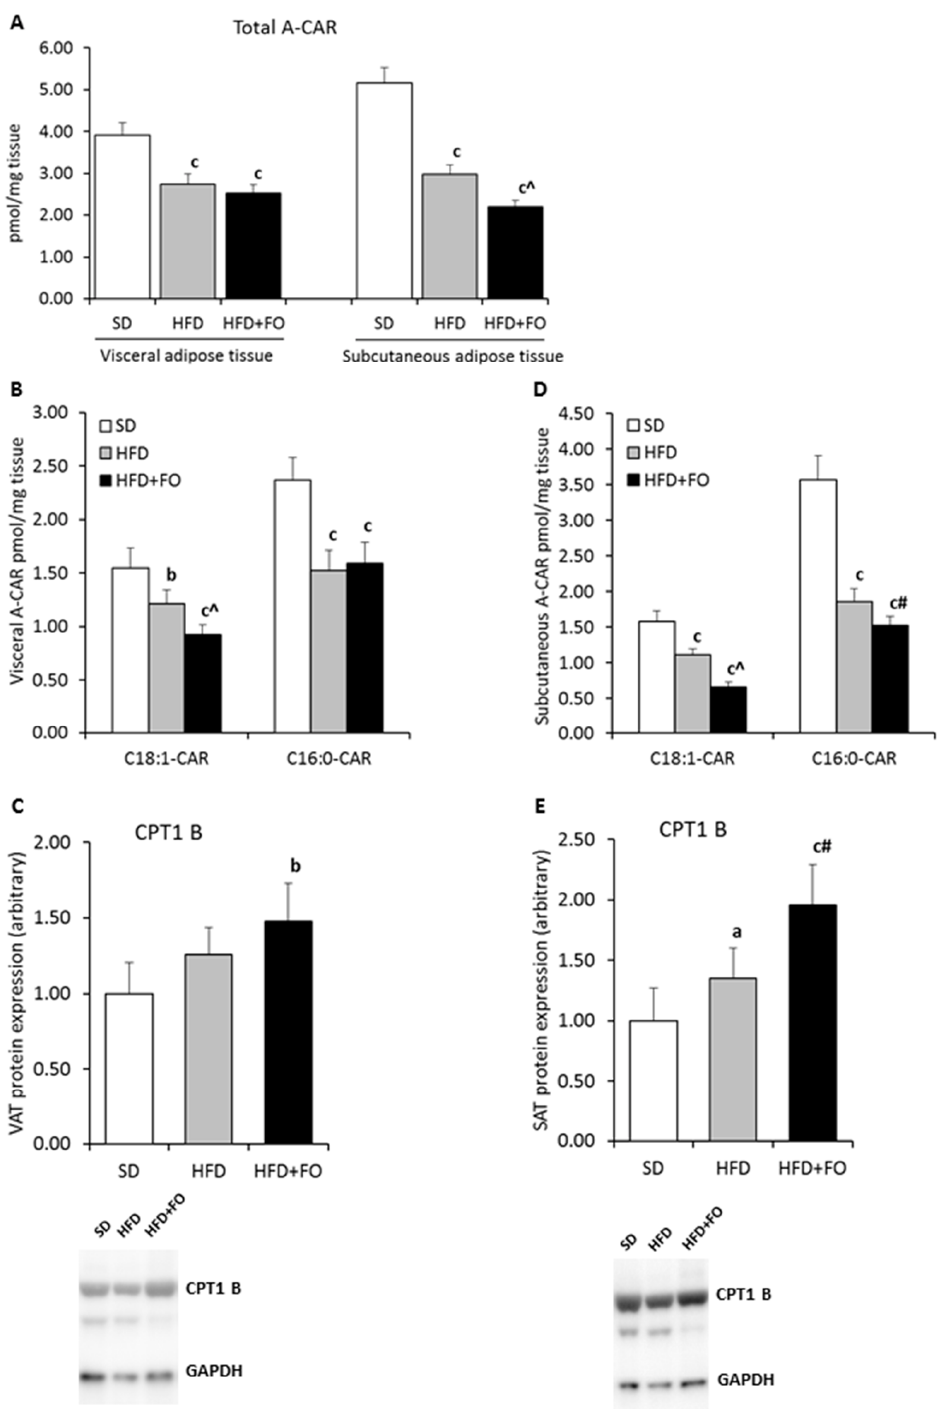
Figure 1. The e ff ect of HFD and HFD + FO consumption on mitochondrial channeling of fatty acids. Panel A presents a total acyl-carnitine (A-CAR) content in rat VAT and SAT, respectively. Panel B and D show the content of A-CAR individual molecular species. Panel C and D present VAT and SAT protein expression of carnitine palmitoyltransferase 1 B (CPT1 B). Values are expressed as mean ± standard deviation. a p < 0.05; b p < 0.01; c p < 0.001—as compared to SD group. # p < 0.01; ˆ p < 0.001—as compared to HFD group, n = 8 per group.